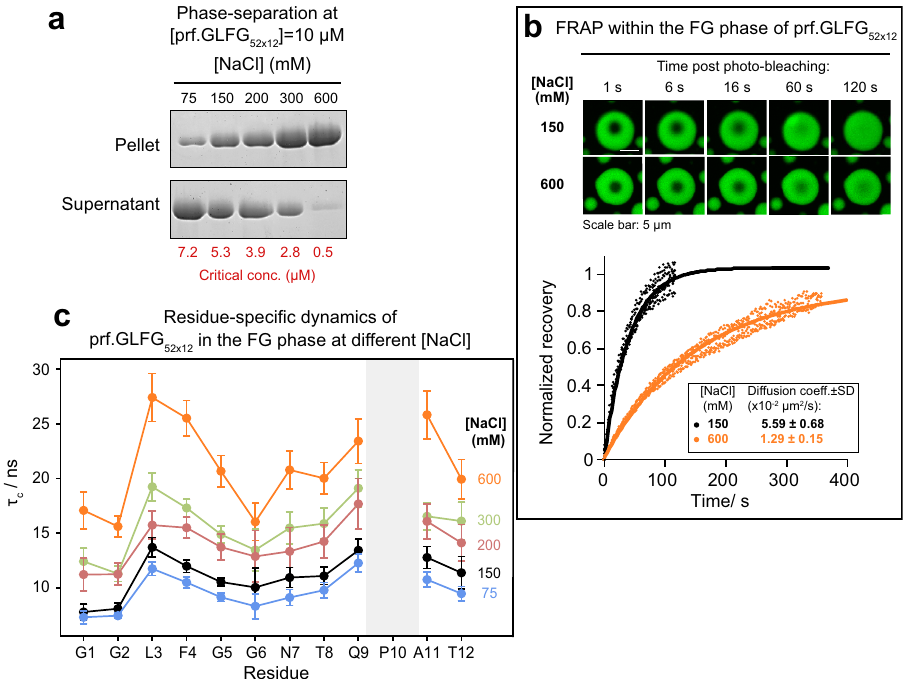
Fig. 5 Effects of salt concentration on the properties of the FG phase. a Analysis of phase separation by centrifugation as described in Fig. 1d with varying [NaCl] at 27 °C. Full scans of gels with molecular weight markers are provided in the Source Data fi le. b FG phase assembled from prf.GLFG 52×12 containing 2.5% Atto488-coupled prf.GLFG 52×12 molecules photobleached in 150 or 600 mM NaCl and the fl uorescence recovery after photobleaching. Top : representative images showing the recovery of Atto488 signal (bleached area: manually de fi ned to be circular with a diameter of ~3 μ m). Bottom : Signal recovery normalized to 1 for a complete recovery plotted against time post bleaching. Fits (solid lines) to fi ve replicates are shown. The translational diffusion coef fi cients (mean ± S.D.) derived from the fi ts are shown in the box. c Residue-speci fi c rotational correlation times ( τ c ) of prf.GLFG 52×12 in FG phase as determined from the [ 15 N, 1 H]-TRACT experiment, shown as a function of [NaCl]. τ c -values are plotted as calculated from the best fi t values of R α and R β from a single measurement. Error bars are shown as ±S.D.s. S.D.s were obtained from the exponential fi ts of the transverse relaxation rates R α and R β , and the Monte Carlo method ( N = 10000) was then used to estimate the S.D.s of τ c . The temperature was set to 36 °C for all measurements. Due to the absence of H N , no TRACT data is available for Pro